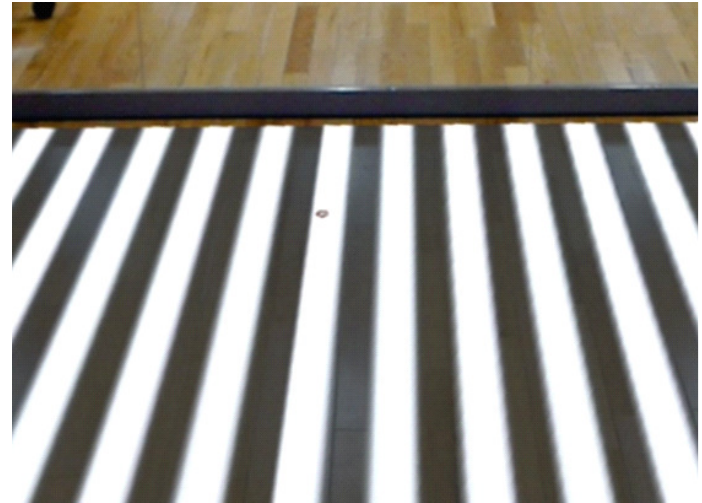
Figure 21. Appearance of AR moving stripes texture.